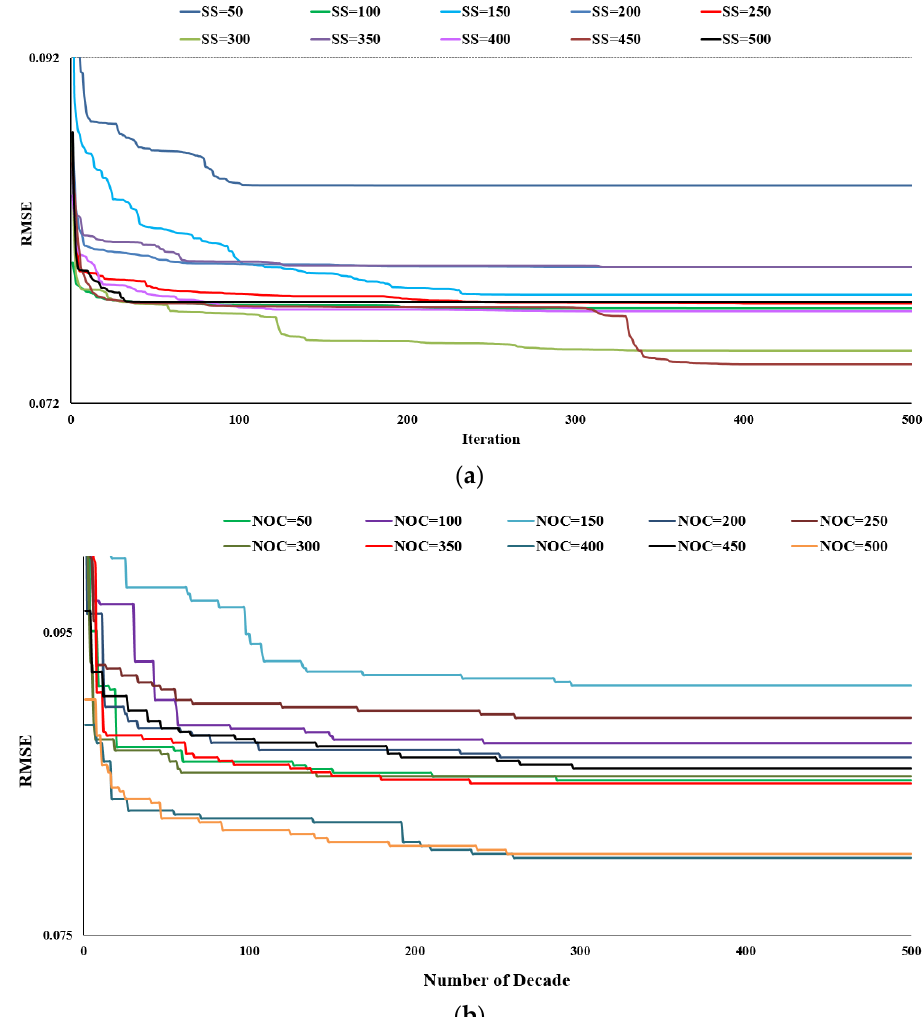
Figure 6. Results of hybrid neuro-based models to predict PPV values. ( a ) 10 models of neuro-swarm; ( b ) 10 models of neuro-imperialism.